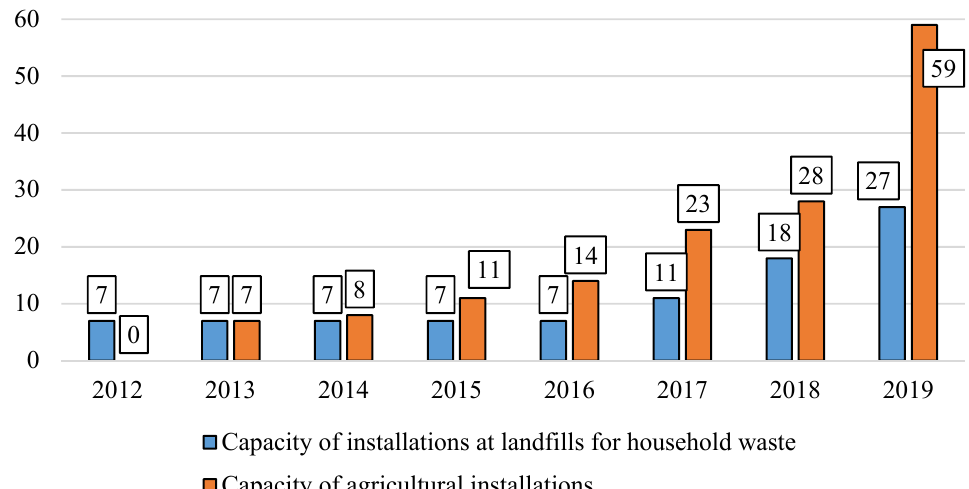
Figure 2. Dynamics of biogas capacity growth in Ukraine, 2012–2019, MW. Source: own elaboration, based on data from The State Agency for Energy Efficiency and Energy Saving of Ukraine [ 9 ].